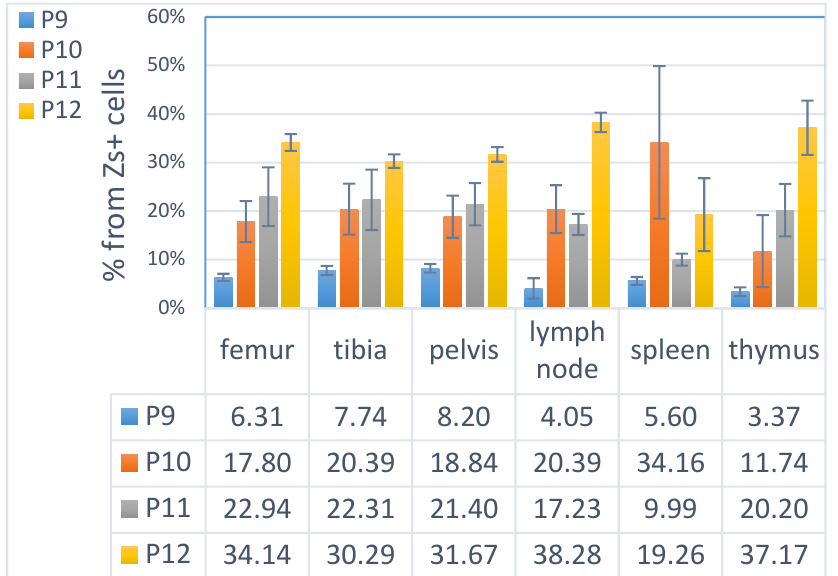
Figure 4. The sub-populations of ML23 distribute broadly in various organs. The average percentage expression (from ZsGreen+ cells) of each of the four sub-populations (P9—12) as measured using FACS analysis for cells extracted from six different tissues of ML23 leukemic mice. Cells were PRE-GATED to ZsGreen+, at least 90% in each sample (not shown). Data are shown from three independent experiments.